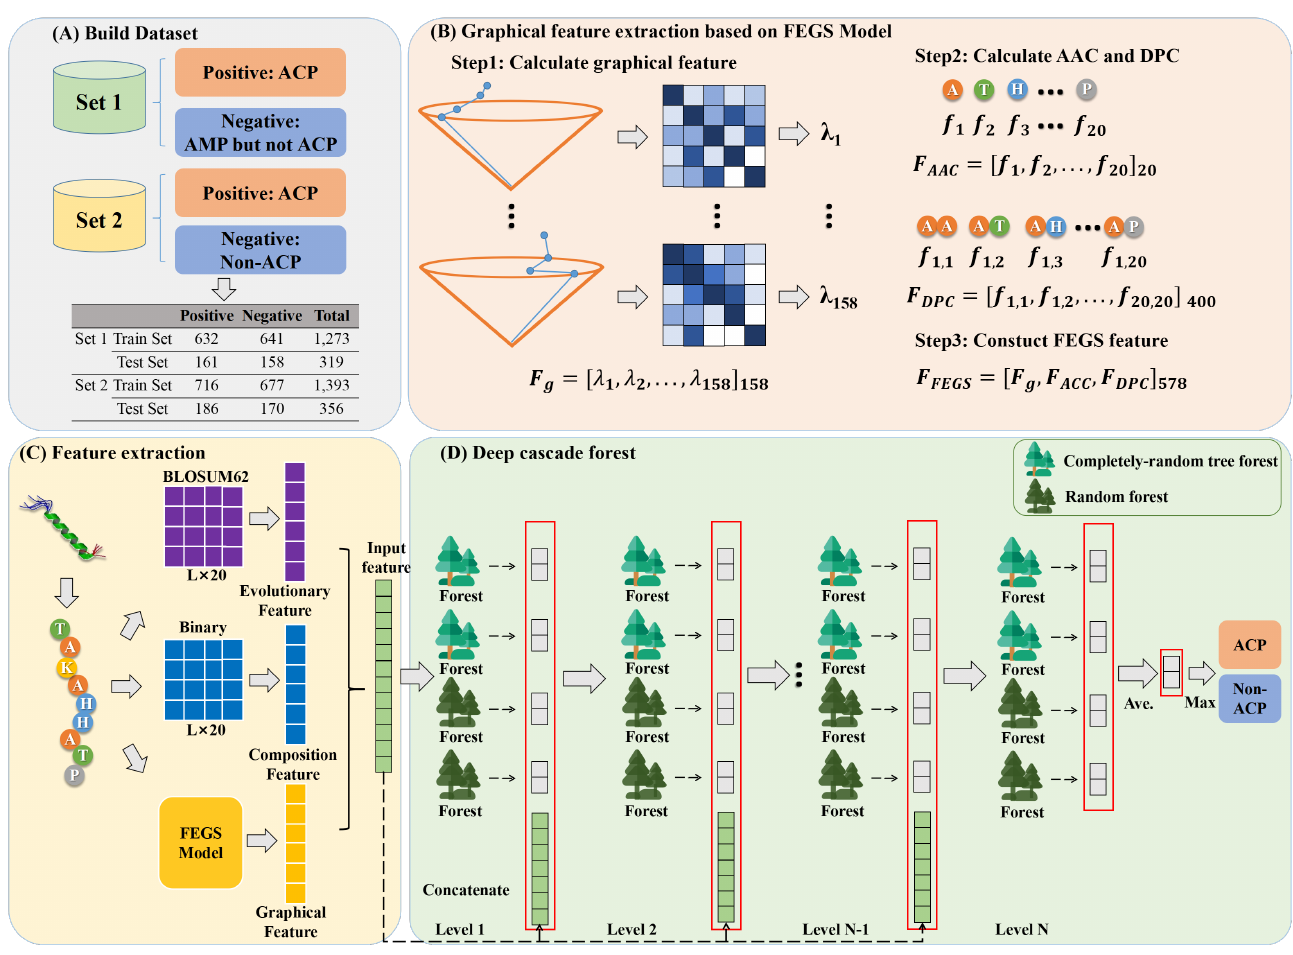
Figure 5. The workflow of GRDF. ( A ) Collection of two datasets (Set 1 and Set 2). ( B ) Graphical feature extraction based on the FEGS model. Each amino acid and amino acid pair is first mapped onto a positive cone of height 1. A 3-dimensional curve is then constructed for each peptide sequence corresponding to each physicochemical property. Each curve is then represented by each symmetry matrix, and this matrix is then characterized by the maximum eigenvalue. In addition, FEGS inte- grates two statistical features, namely ACC and DPC. ( C ) Feature combination of FEGS, BLOSUM62, and Binary profile. ( D ) Cascade forest architecture. Deep forest performs representation learning of features through a layer-by-layer cascade structure similar to that of deep neural networks. Each layer of the cascade is a forest-based